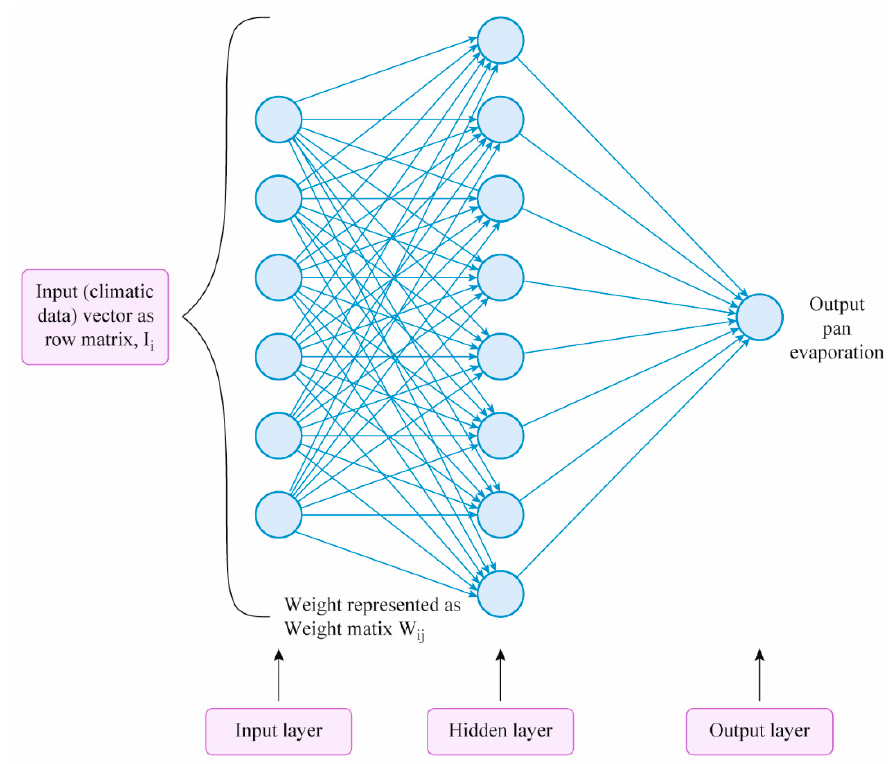
Figure 4. Illustration of the application of feedforward artificial neural networks (ANNs) in modeling pan evaporation rates.